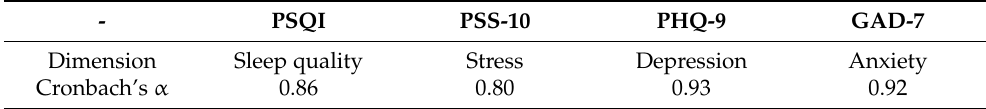
Table 1. Internal consistency of the